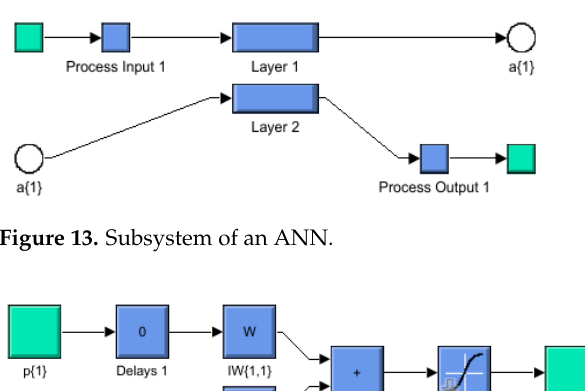
Figure 12. Simulink model of an ANN.